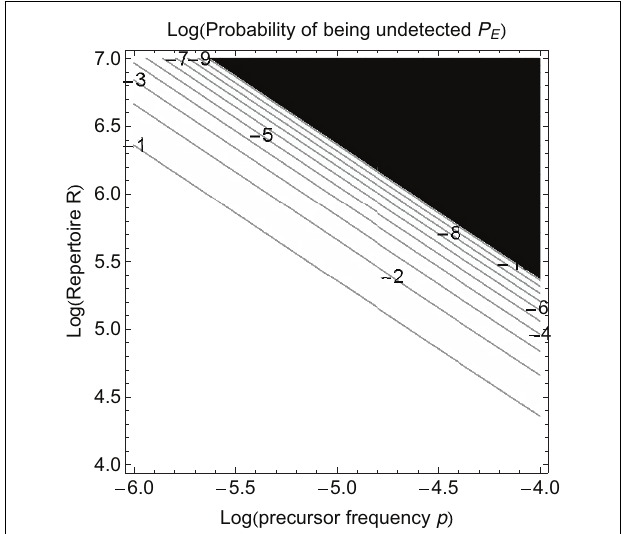
FIGURE 2 |The probability a pathogen is not detected, P E , as a function of the log of the precursor frequency p and the log of the naïve T cell repertoire R .The numbers on the contour lines in the plot indicate log P E values. Black color corresponds to the values of P E below the threshold of 10 − 10 .